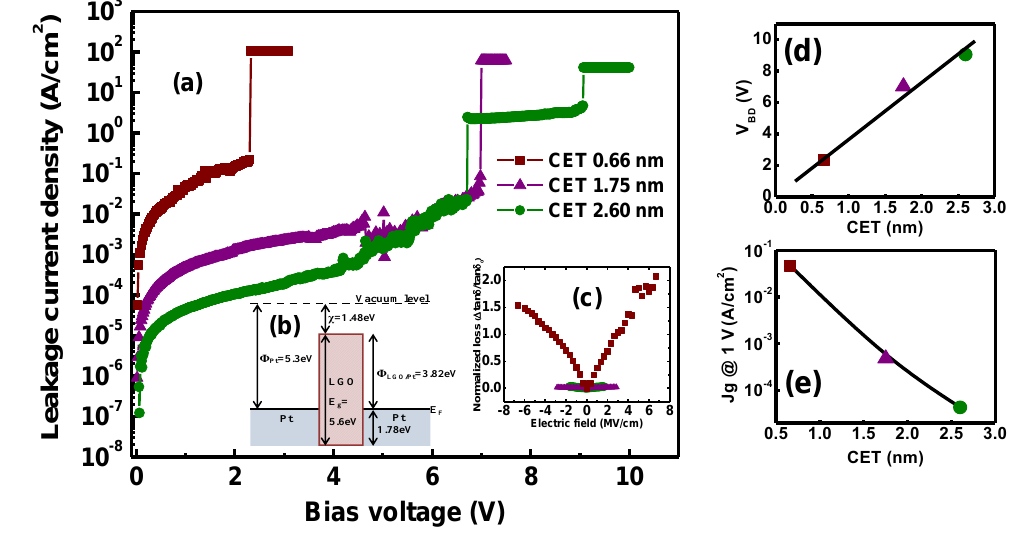
Figure 20. ( a ) The thickness dependence of the leakage current density-bias voltage plots of Pt/LaGdO /Pt MIM capacitors; ( b ) the energy band match-up diagram of the 3 Pt/LaGdO /Pt MIM structure under the zero bias condition showing the larger LaGdO 3 Schottky barrier height; ( c ) the normalized loss tangent as a function of the applied electric field; ( d ) the linear evolution in breakdown voltage with CET; ( e ) the leakage current density at a 1 V bias voltage for various CETs. Reprinted with permission from